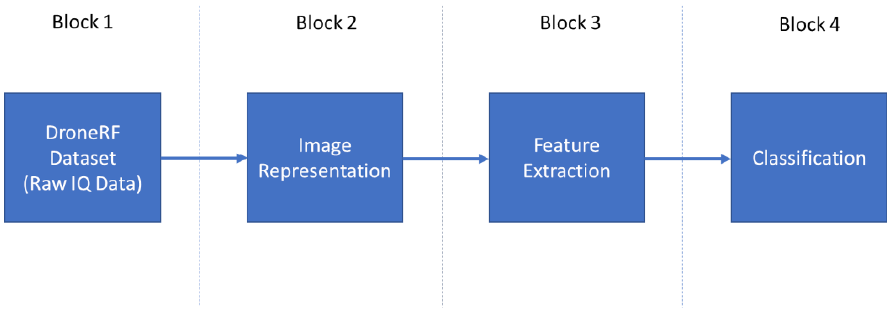
Figure 1. Block diagram of the overall